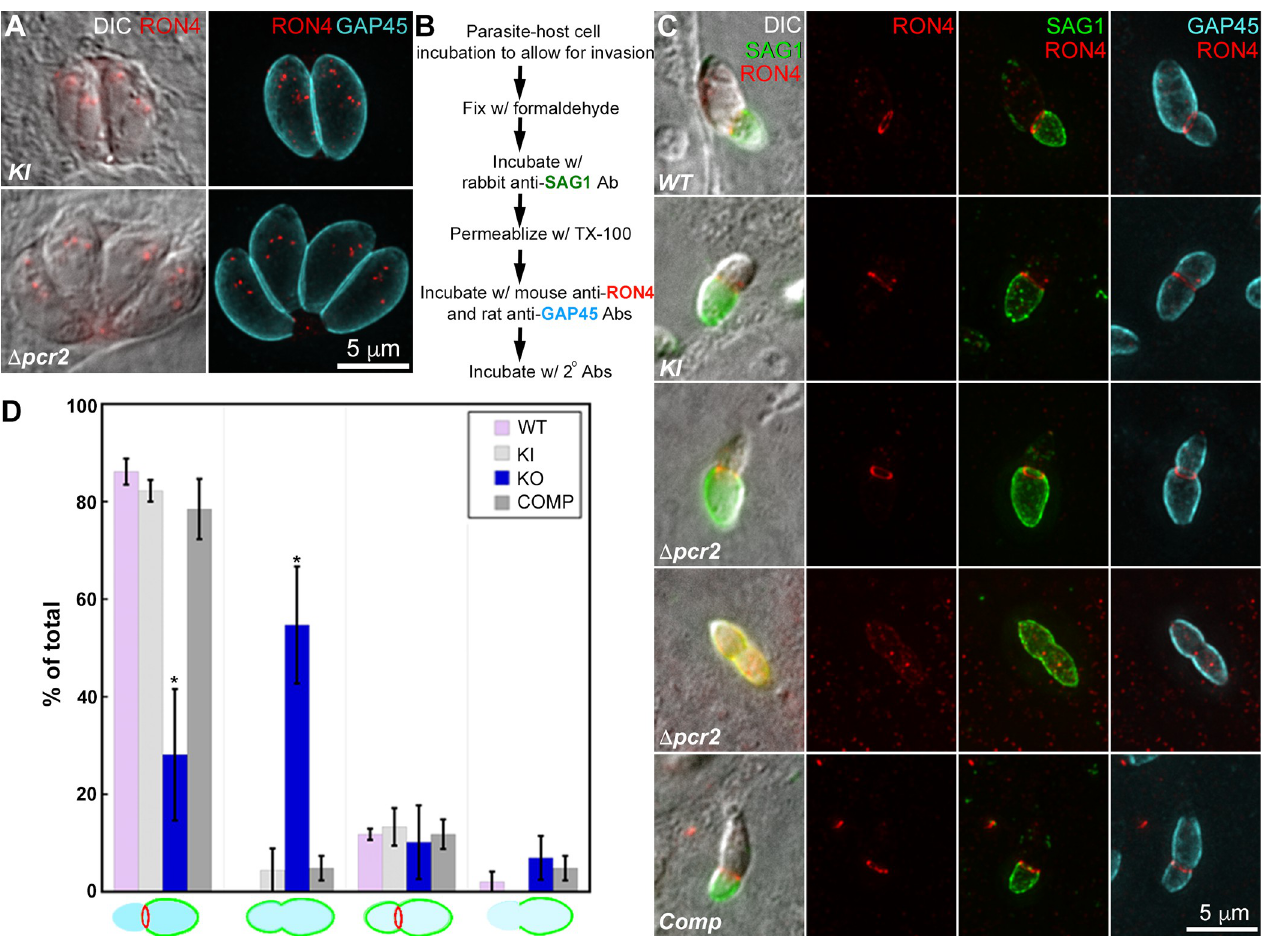
Fig 10. Δ pcr2 parasites are defective in assembling the moving junction. A. Projections of deconvolved wide-field fluorescence images of intracellular mE-Pcr2 KI ( KI ) and Δ pcr2 parasites labeled with a mouse anti-RON4 (red), a rat anti-GAP45 (cyan) and corresponding secondary antibodies. B. Outline of a pulse invasion assay to analyze the assembly of the moving junction (marked by anti-RON4 labeling), and the differential accessibility of the intracellular vs extracellular portion of the invading parasites to antibody labeling of the SAG1 surface antigen. C. DIC and projections of deconvolved wide-field fluorescence images of RH Δ hx Δ ku80 ( WT ), mEmeraldFP-Pcr2 knock-in ( KI ), knockout ( Δ pcr2 ) and complemented (Comp) parasites, in which SAG1 (green) RON4 (red), and GAP45 (cyan) were labeled by immunofluorescence in the pulse invasion assay described in B. Two predominant patterns are included. D . Quantification of all four SAG1 and RON4 labeling patterns observed in WT , KI , Δ pcr2 and complemented (Comp) parasites from three independent biological replicates. Error bars: standard error. � P value < 0.05 (unpaired Student’s t-tests), when compared with WT